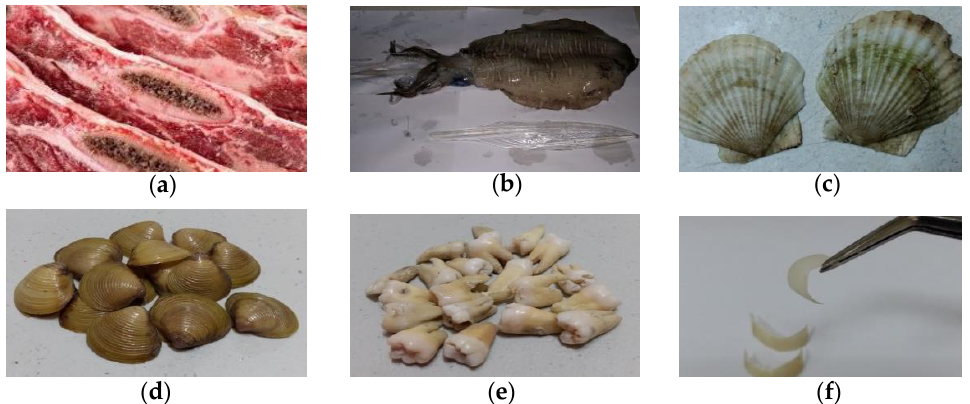
Figure 1. Biological samples of ( a ) ox bone, ( b ) chitin, ( c ) cyclina shell, ( d ) clam shell, ( e ) tooth and ( f ) fingernail.